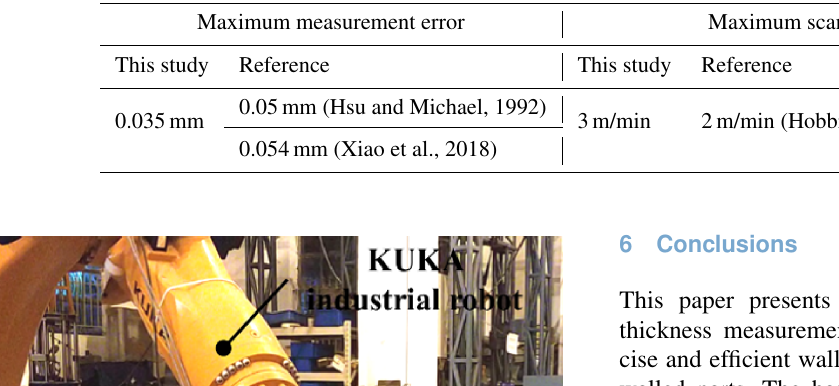
Table 1. Comparison of the accuracy and efficiency of ultrasonic wall thickness measurement.